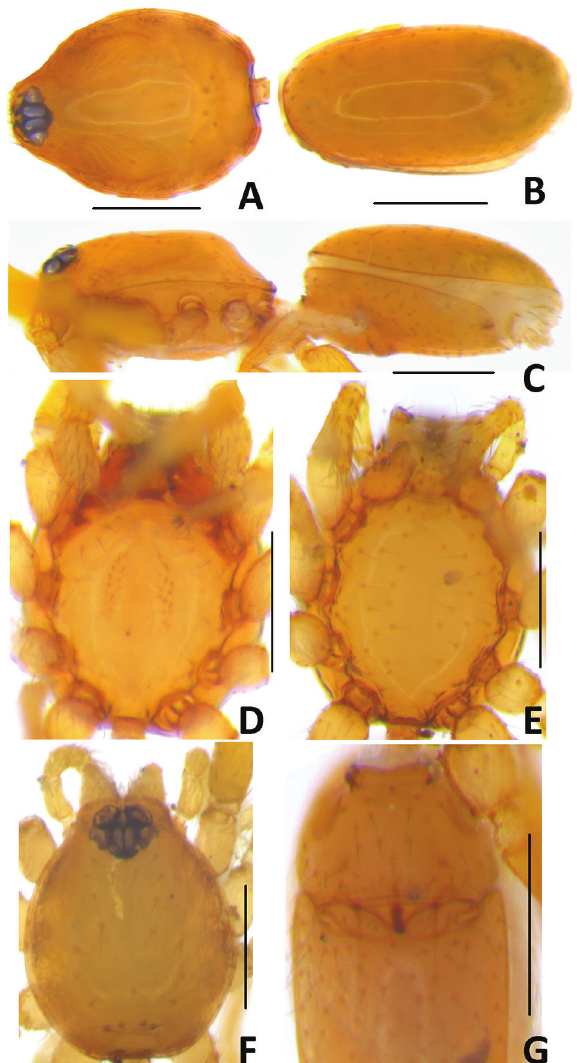
Figure 1. Cavisternum bom n. sp., Male ( A–D ), female ( E–G ) from Mandaitivu FR: A , carapace, dorsal view; B , abdomen, dorsal view; C , habitus, lateral view; D , sternum, ventral view; E , same; F , carapace, dorsal view; G , abdomen, ventral view. Scale bars: 0.2